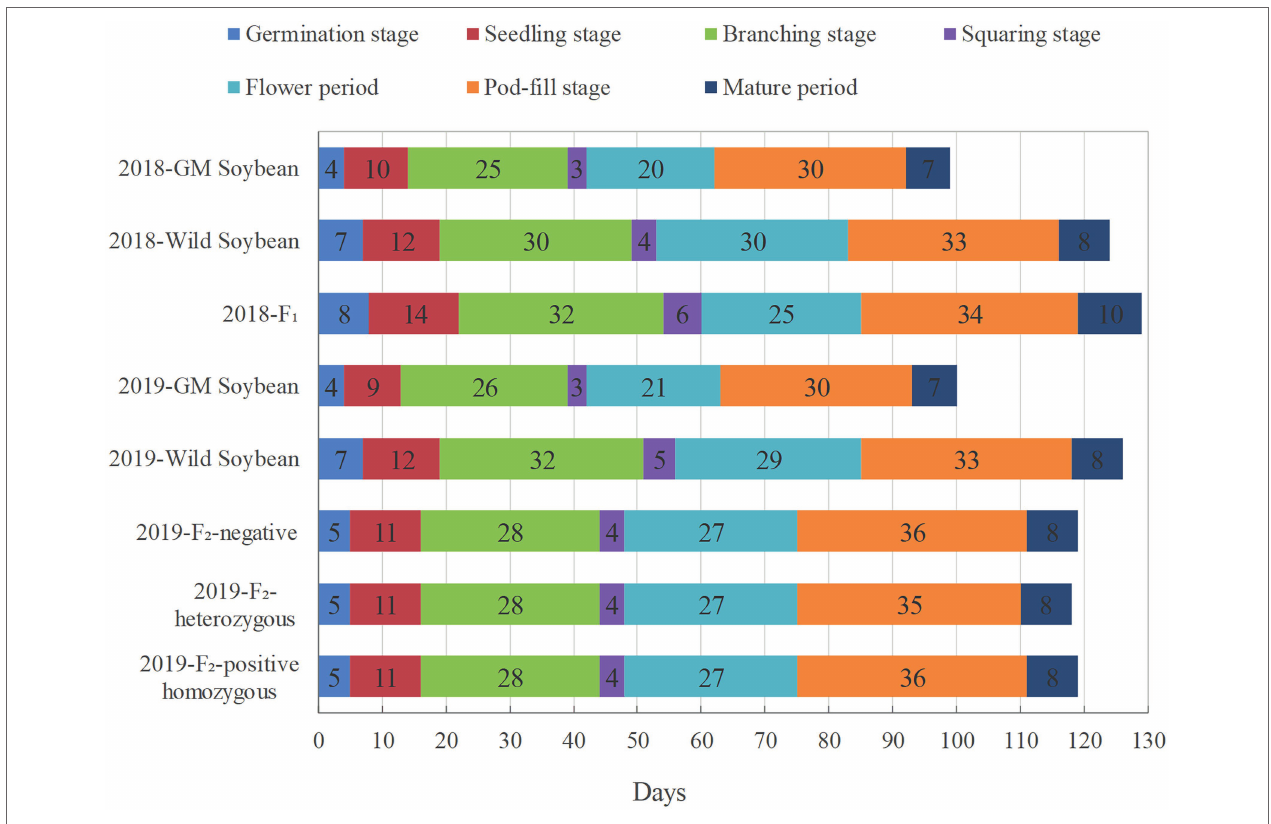
FIGURE 2 | Growth periods of genetically modified, wild soybeans, and hybrid offspring